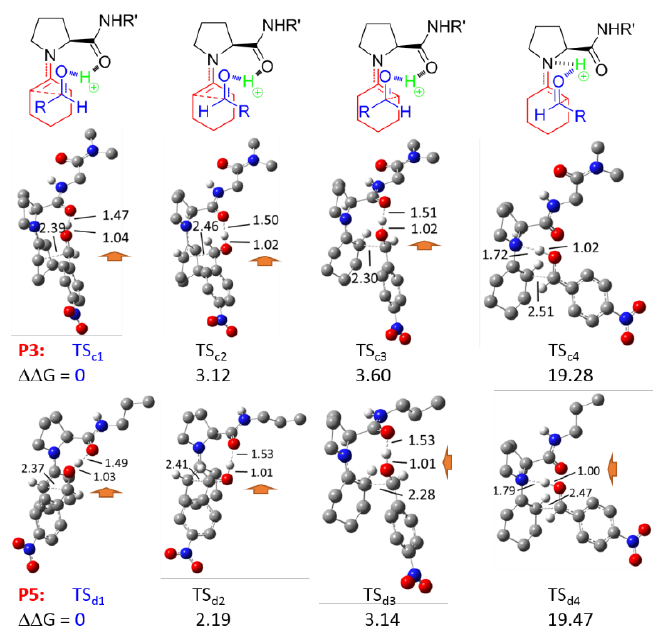
Figure 3. Optimized enamine / aldehyde reaction transition states in the P3 - / P5 -catalyzed aldol addition of cyclohexanone to 4-nitrobenzaldehyde in the presence of acidic additives. Relative energy barriers (in kcal/mol) and relevant geometric parameters are shown (in Å ). Partial hydrogen atoms are hidden for clarity.